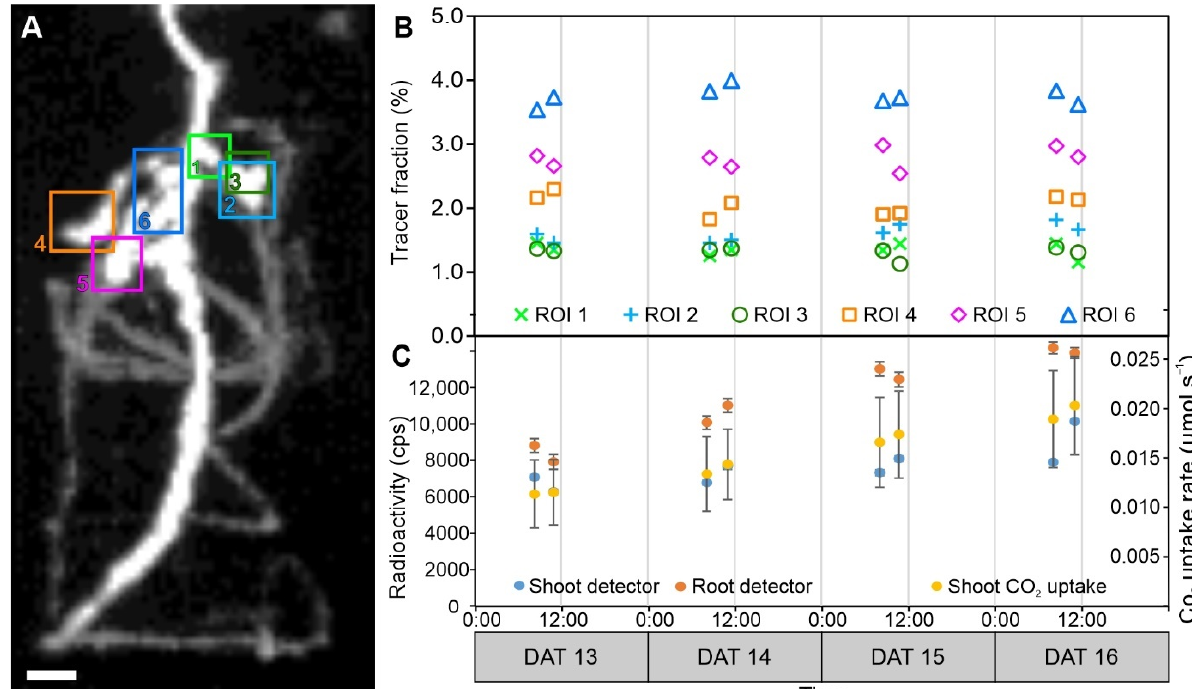
Figure 4. Example for carbon tracer allocation to whole root system and selected nodule ROIs of a pea ( Pisum sativum L.) plant. ( A ) Two-dimensional projection of carbon tracer distribution within the nodulated root system obtained from PET data, overlaid with positions of 6 ROIs (numbered 1 to 6) enclosing selected nodules. Scale bar, 10 mm. Projections with ROIs from all spatial directions can be found in Figure S4. ( B ) Mean tracer fractions in ROIs from ( A ) (corresponding color) compared to total tracer detected in the root system, determined according to Figure 3D on four days with two measurements per day. Standard deviation (SD) was lower than marker size. ( C ) Radioactivity measured by a shoot and a root scintillation detector for the same timespan (75–105 min) as used for the calculation of the tracer fractions. Units are counts per second (cps), decay corrected mean ± SD. Whole plant shoot CO 2 uptake rate (mean ± SD) was determined over the full measurement period of 2 h. Note that while numbers for root and shoot detector appear to be similar, the radioactivity was much higher in the shoot, where a less sensitive detector was used to prevent excessive dead time effects. DAT, days after transfer to pots.